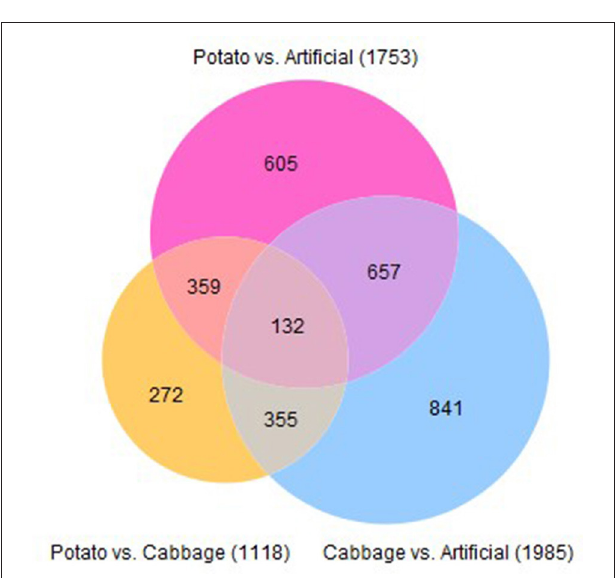
FIGURE 5 | Venn diagram describing the number of contigs significantly differentially expressed in midguts of 4th instar T. ni raised on three diets.